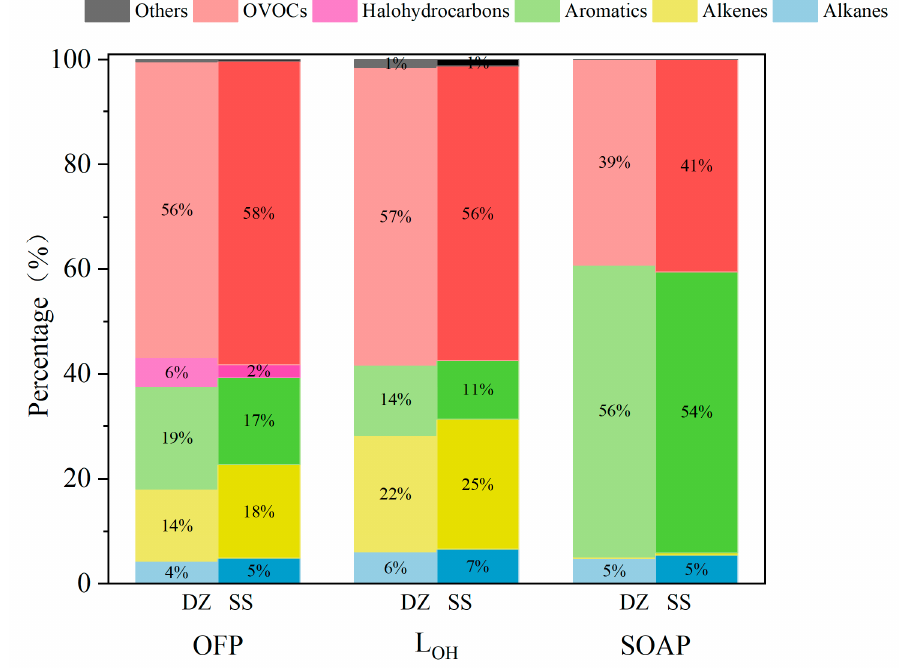
Figure 5. Contributions of VOCs groups to the total OFP, L OH and SOAP at DZ and SS sites. The total L OH for all the measured VOCs was 26.6 s − 1 and 31.7 s − 1 for the DZ and SS sites, respectively. The results of the contribution of each VOCs group to L OH were similar to those of OFP, with OVOCs as the most important component of L OH (56–57%), followed by alkenes (22–15%), aromatics (11–14%) and alkanes (6–7%). Halogenated hydrocarbons with very low photochemical reactivity were not involved in the calculation of L OH in this